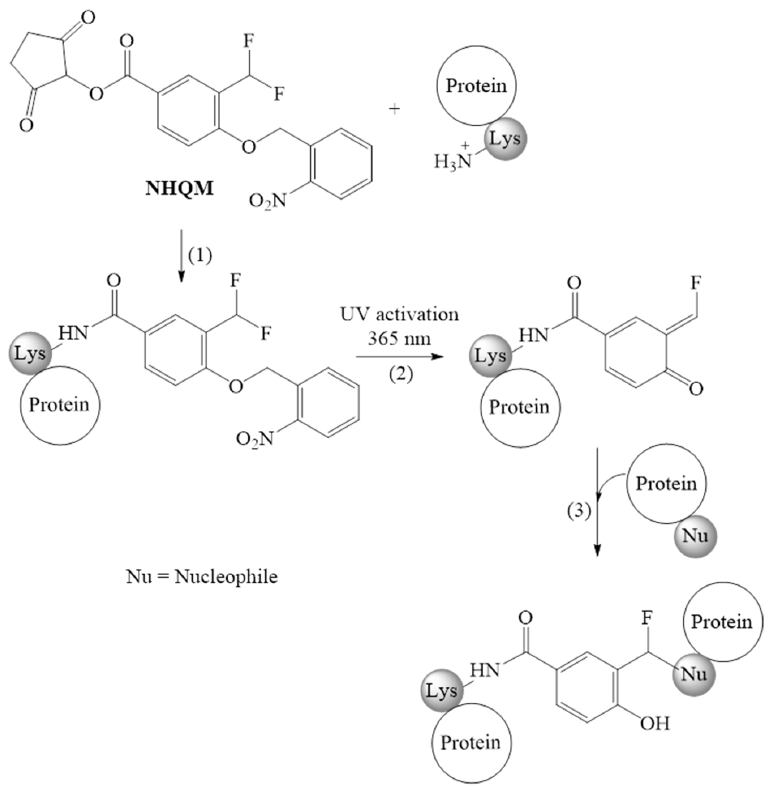
Figure 10. Crosslinking of two proteins of close proximity by a heterobifunctional cross ‐ linker, NHQM, with an NHS ester and a photocaged ortho ‐ Quinone Methides ( o ‐ QM), where (1) NHS ester rapidly reacts with amine groups of lysine amino acids of proteins, followed by (2) exposure to UV (365 nm) activating the more reactive o ‐ QM that (3) reacts with multiple nucleophilic (Nu) amino acids.